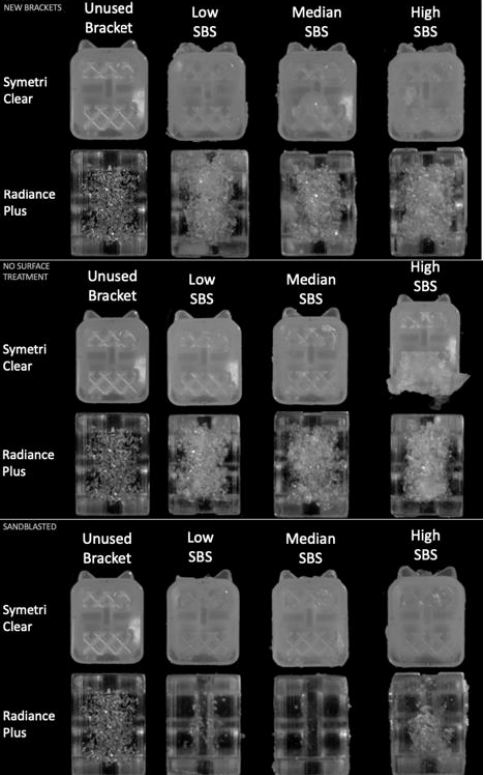
Figure 1. Stereomicroscope Images of low/median/high shear bond strength for new (N), rebonded and no-surface treatment (R-NST), and rebonded and sandblasted (R-SB) representative samples.